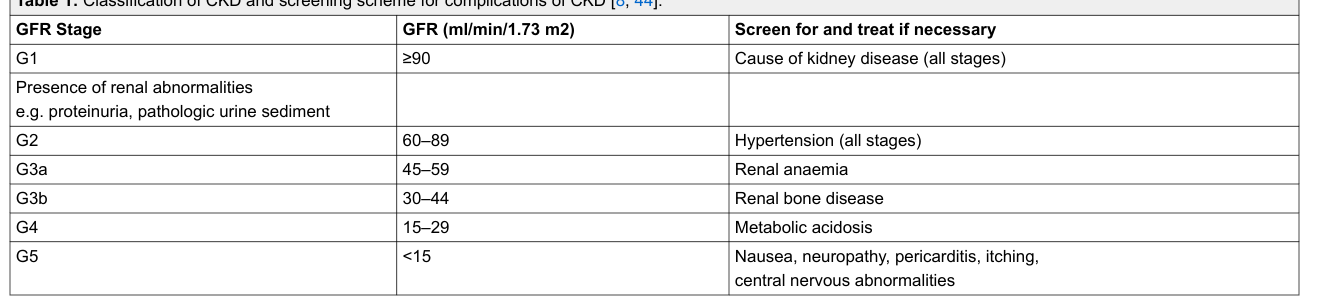
Table 1: Classification of CKD and screening scheme for complications of CKD [8, 44]. GFR Stage GFR (ml/min/1.73 m2) Screen for and treat if necessary G1 ≥90 Cause of kidney disease (all stages) Presence of renal abnormalities e.g. proteinuria, pathologic urine